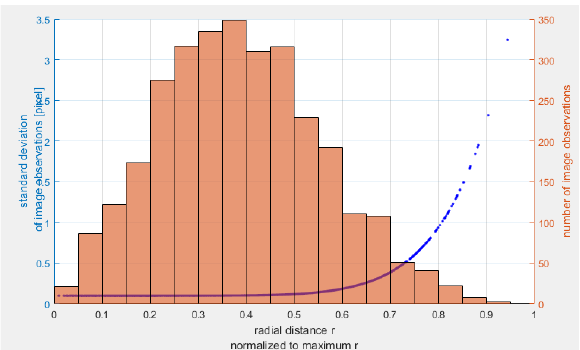
Figure 7. Histogram of image observations as function of normalised radial distance for the dataset #1_Cal_FLAT Quercianella . The blue curve represents the empirical standard deviations employed to weight the image observations in the bundle